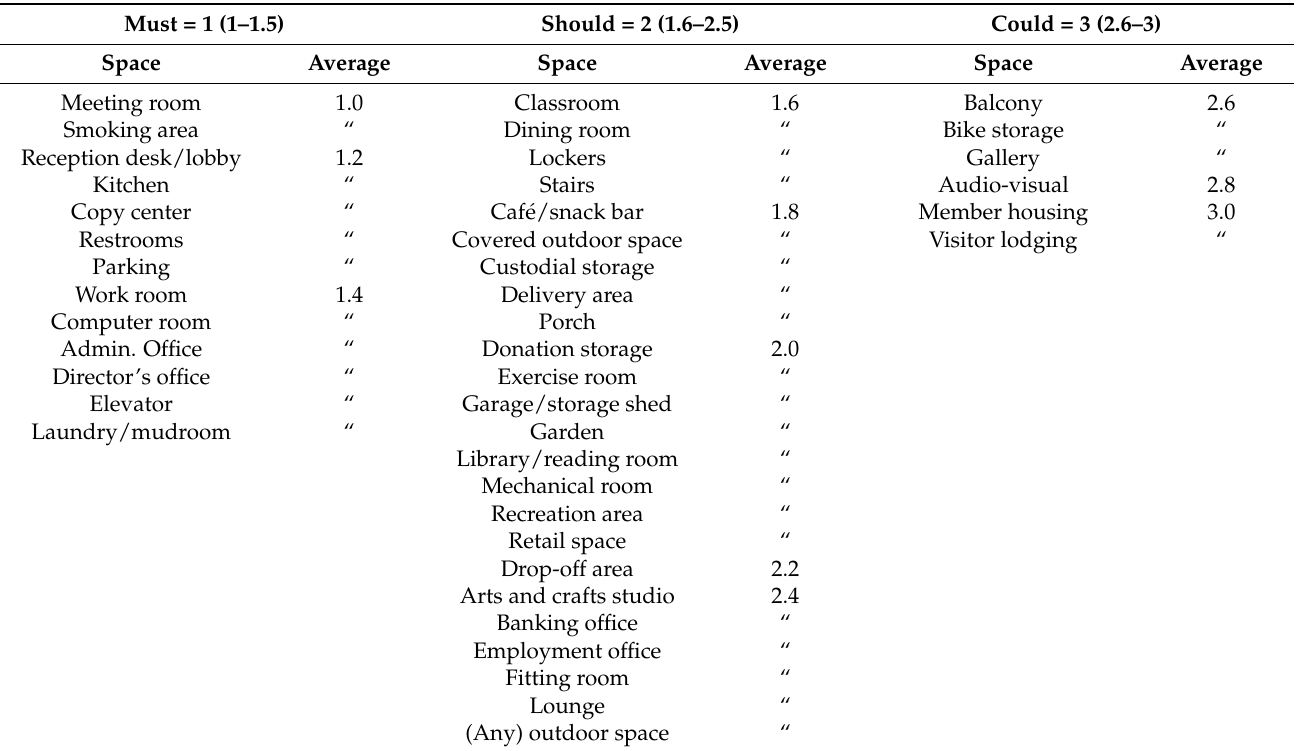
Table 1. Average priority rankings of future Clubhouse spaces completed by members.